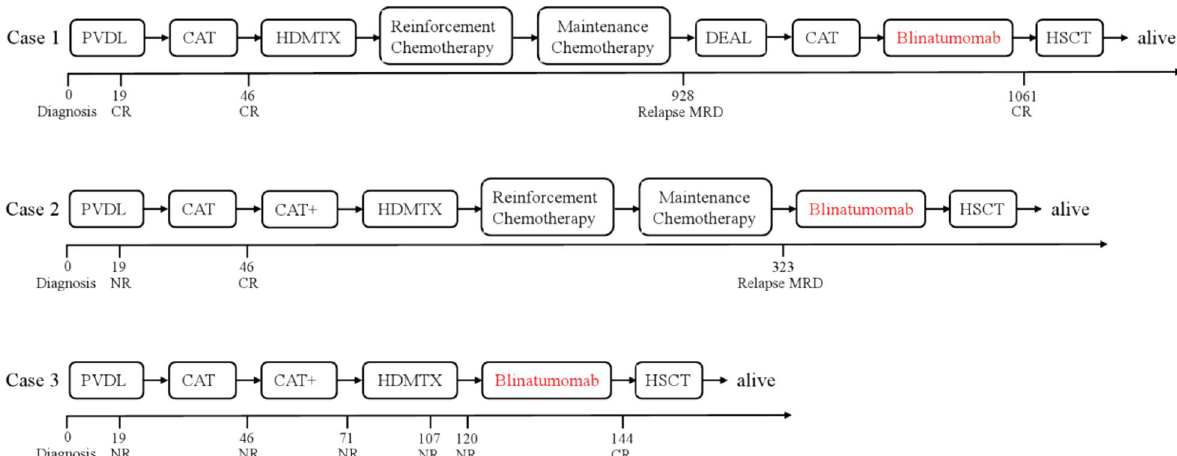
Fig. 2 Flowchart of the treatment protocol used in the three cases. PVDL, prednisolone, vincristine, daunorubicin and L-asparaginase; CAT, cyclophosphamide, cytarabine and mercaptopurine; HDMTX, high-dose methotrexate; DEAL, dexamethasone, cytarabine, etoposide and L-asparaginase; HSCT, hematopoietic stem cell transplantation; CAT , cyclophosphamide, cytarabine, mercaptopurine, vincristine and + L-asparaginase, with or without